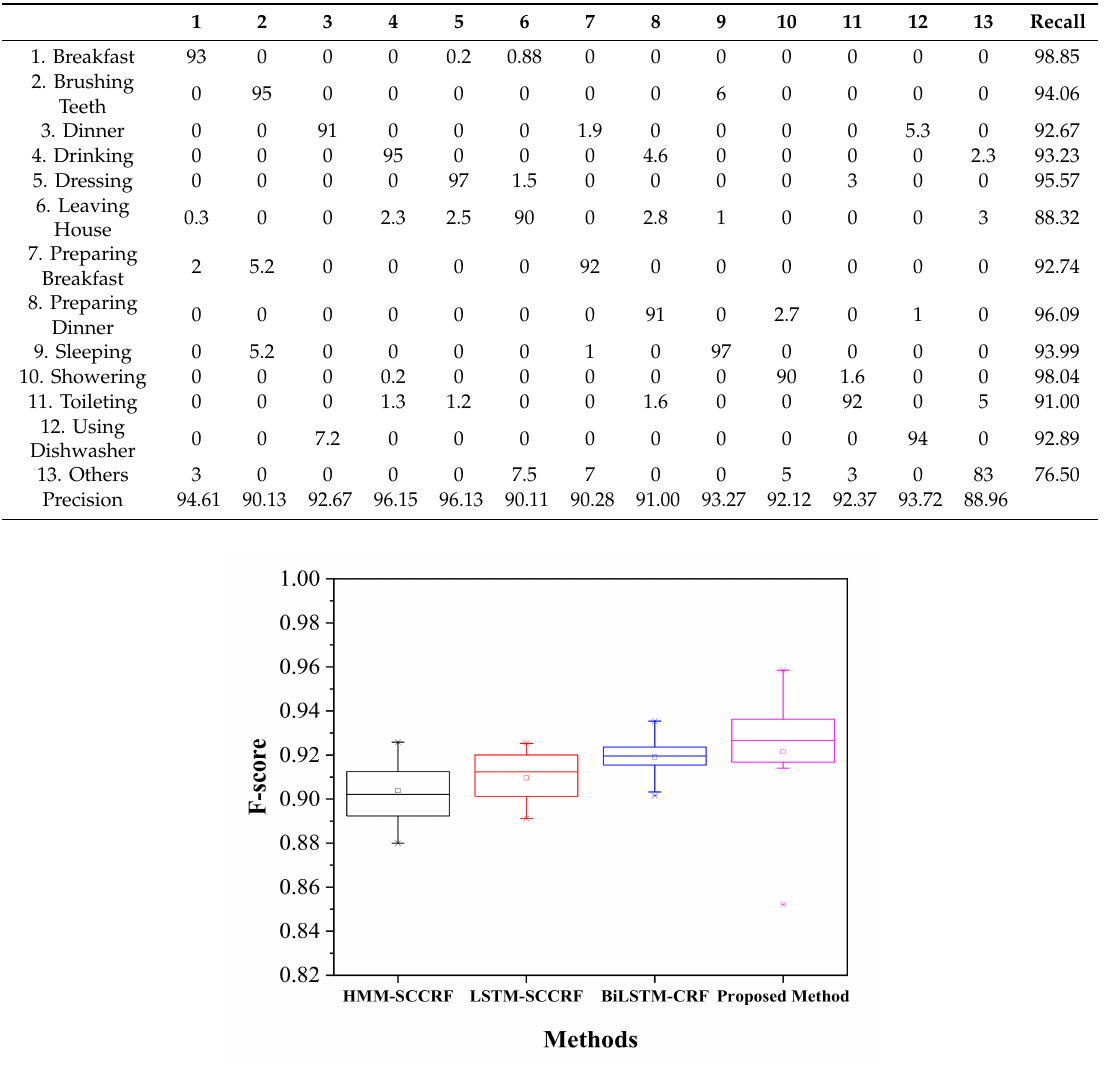
Figure 14. F-score comparison on